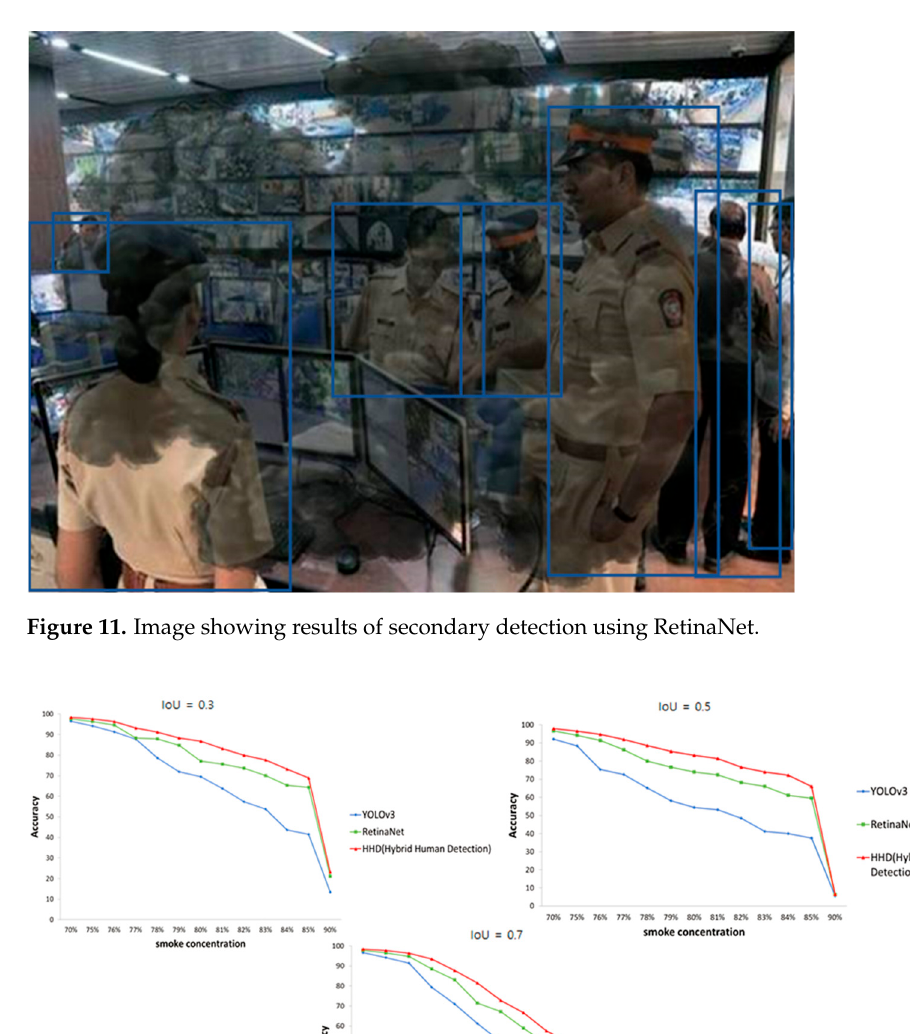
values of 0.3, 0.5, and 0.7.